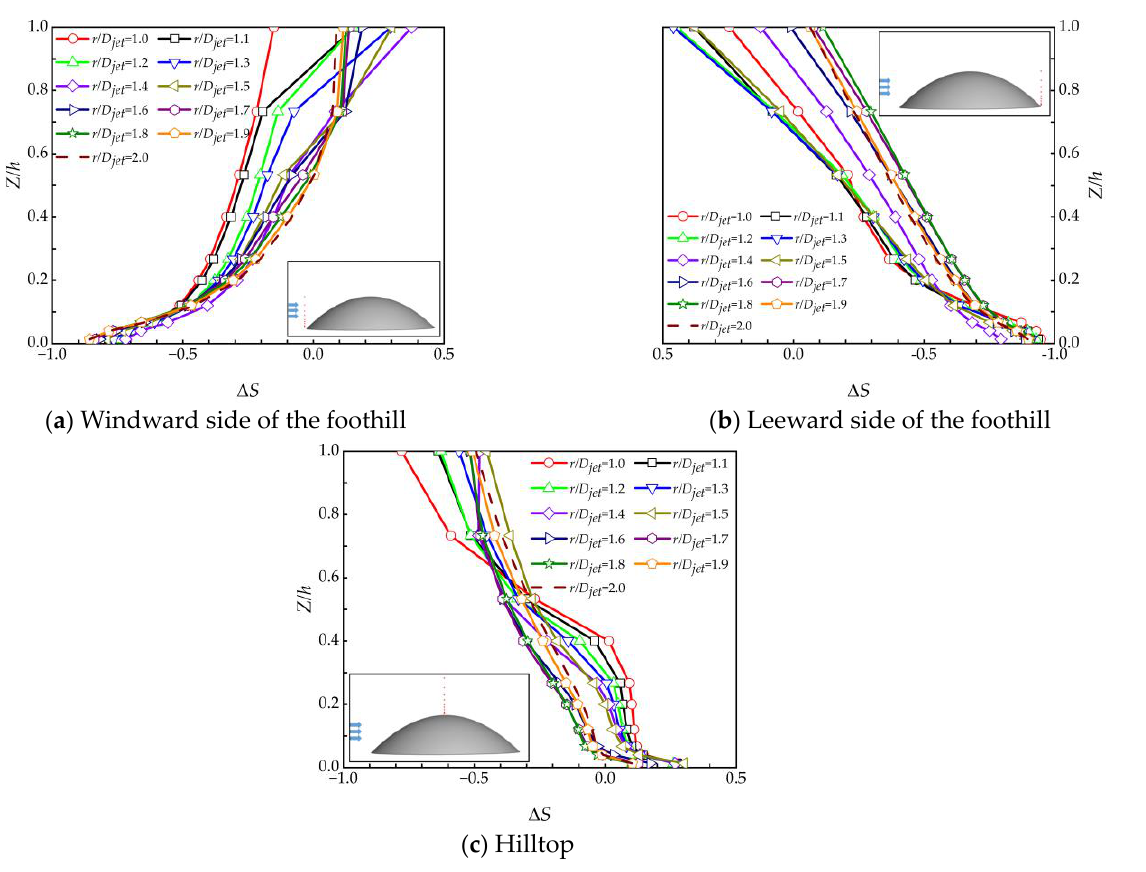
Figure 5. Speedup ratio of the hill with different radial positions.